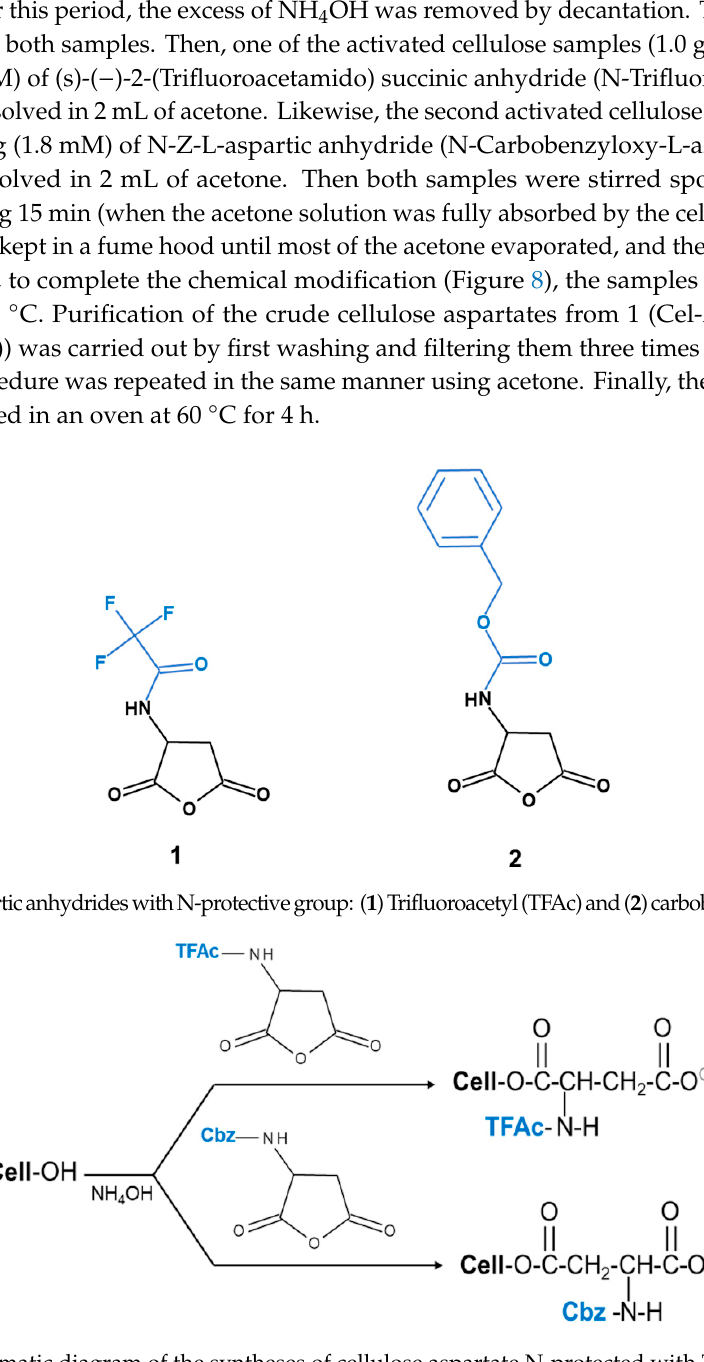
Figure 8. Schematic diagram of the syntheses of cellulose aspartate N-protected with TFAc and Cbz.